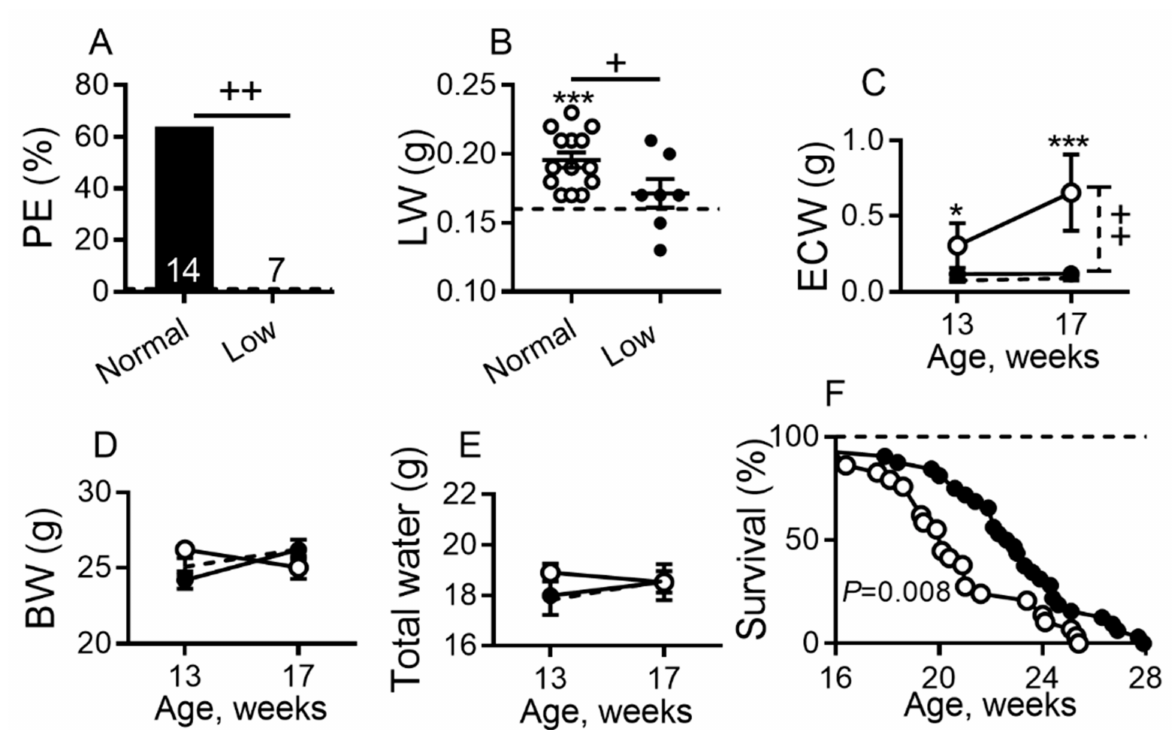
Figure 2. Dietary sodium restriction suppresses pleural effusions, edema and prolongs survival in mice with DCM on a normal or low sodium (low) diet. ( A ) Pleural effusions (PE) prevalence; bars represent percent of affected mice out of total mice in each group. PE was not detected in any wild-type (WT) controls. ( B ) Lung weight (LW). ( C – E ) Age-related changes corresponding to HF progression from C to D stages in ( C ) extracellular water (ECW), ( D ) body weights (BW), and ( E ) total water. ( A , B ): Groups were 20 weeks of age; DCM mice on normal-sodium diet (NSD) n = 14, on low-sodium diet (LSD) n = 7; WT mice (dashed line, n = 9). ( C – E ): DCM mice enrollment n = 9–11 per group; WT (dashed line, n = 14–15 per group). ( F ) Kaplan–Meier survival curves of DCM mice receiving LSD ( n = 32 deaths) vs. NSD ( n = 29 deaths); WT controls (dashed line, n = 8–10). DCM mice on LSD (closed symbol) or NSD (open symbol). Data are presented as mean ± SEM. *** p < 0.001, * p < 0.05 (DCM vs. WT) mice, ++ p < 0.01, + p < 0.05 (DCM on NSD vs. DCM on LSD). Data were assessed by a Fisher’s exact test ( A ), by one-way analysis of variance (ANOVA) with Newman–Keuls multiple comparison test ( B ), by two-way ANOVA with Bonferroni multiple comparison test ( C – E ) or by the Kaplan–Meier method and the log-rank (Mantel–Cox) test ( F